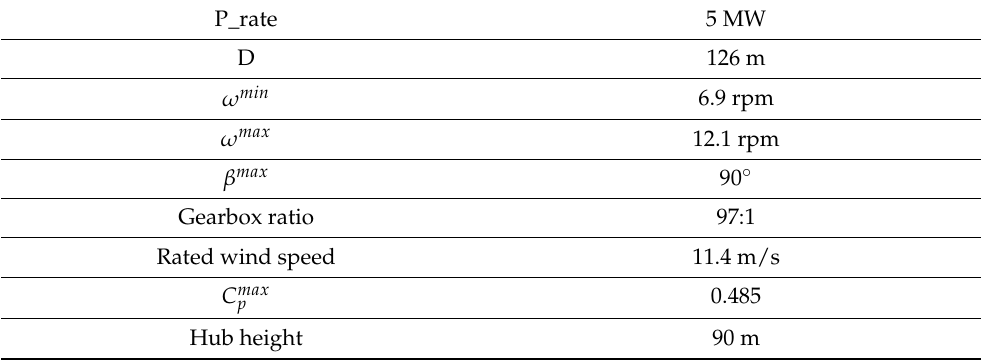
Table A1. The main parameters of the 5 MW wind turbine for an offshore wind